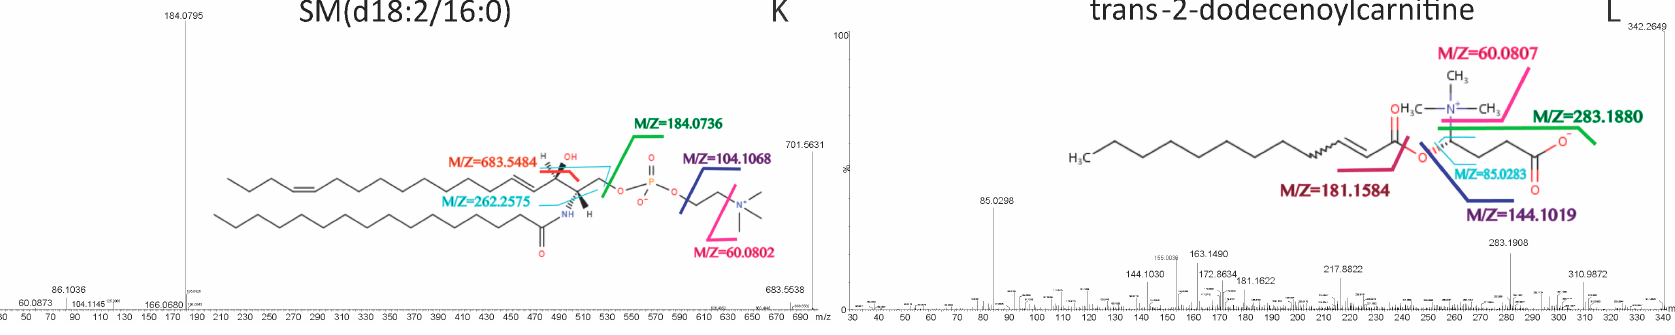
Figure 3. MS/MS mass spectra and predicted structures with expected fragmentation profiles of the 12 biomarkers in melioidosis patient plasma: ( A ) L -octanoylcarnitine; ( B ) decanoylcarnitine; ( C ) dodecanoylcarnitine; ( D ) lysophosphatidylethanolamine (LysoPE)(16:0/0:0); ( E ) LysoPE(18:0/0:0); ( F ) phosphatidylcholine PC(16:0/16:0); ( G ) LysoPE(0:0/18:0) ( H ) L -hexanoylcarnitine; ( I ) sphingomyelins SM(d16:1/16:0); ( J ) 2-decenoylcarnitine; ( K ) SM(d18:2/16:0); and ( L ) trans -2-dodecenoylcarnitine with or without comparison to commercially available standards.